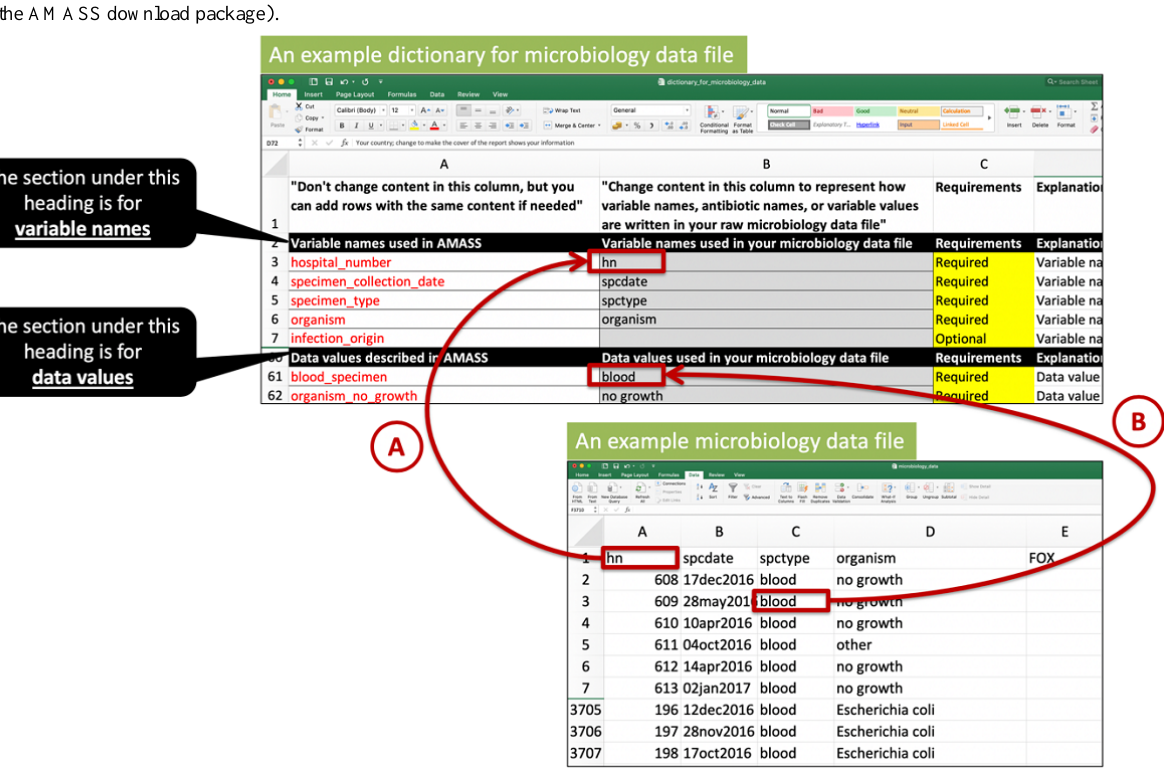
Figure 2. An example of how to complete a data dictionary file. For a first-time user, the user may need to complete a data dictionary file by filling in variable names used in the raw data files into the data dictionary files (eg, arrow A). This is to allow the AutoMated tool for Antimicrobial resistance Surveillance System (AMASS) to understand that the variable “hospital_number” used by the AMASS is named as “hn” in the user’s raw microbiology data file. Thereafter, users need to enter how data values are named in their raw data files (e.g. arrow B). This is to allow the AMASS to